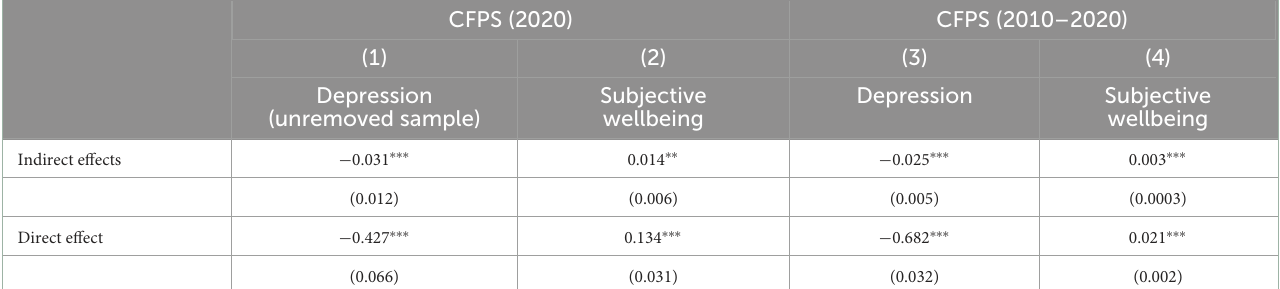
TABLE 4 Robustness test